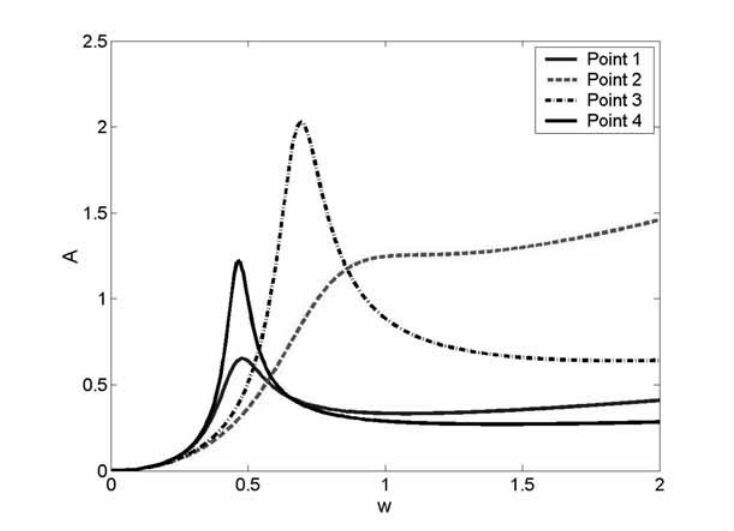
Fig. 27. Optimized absolute acceleration frequency response.